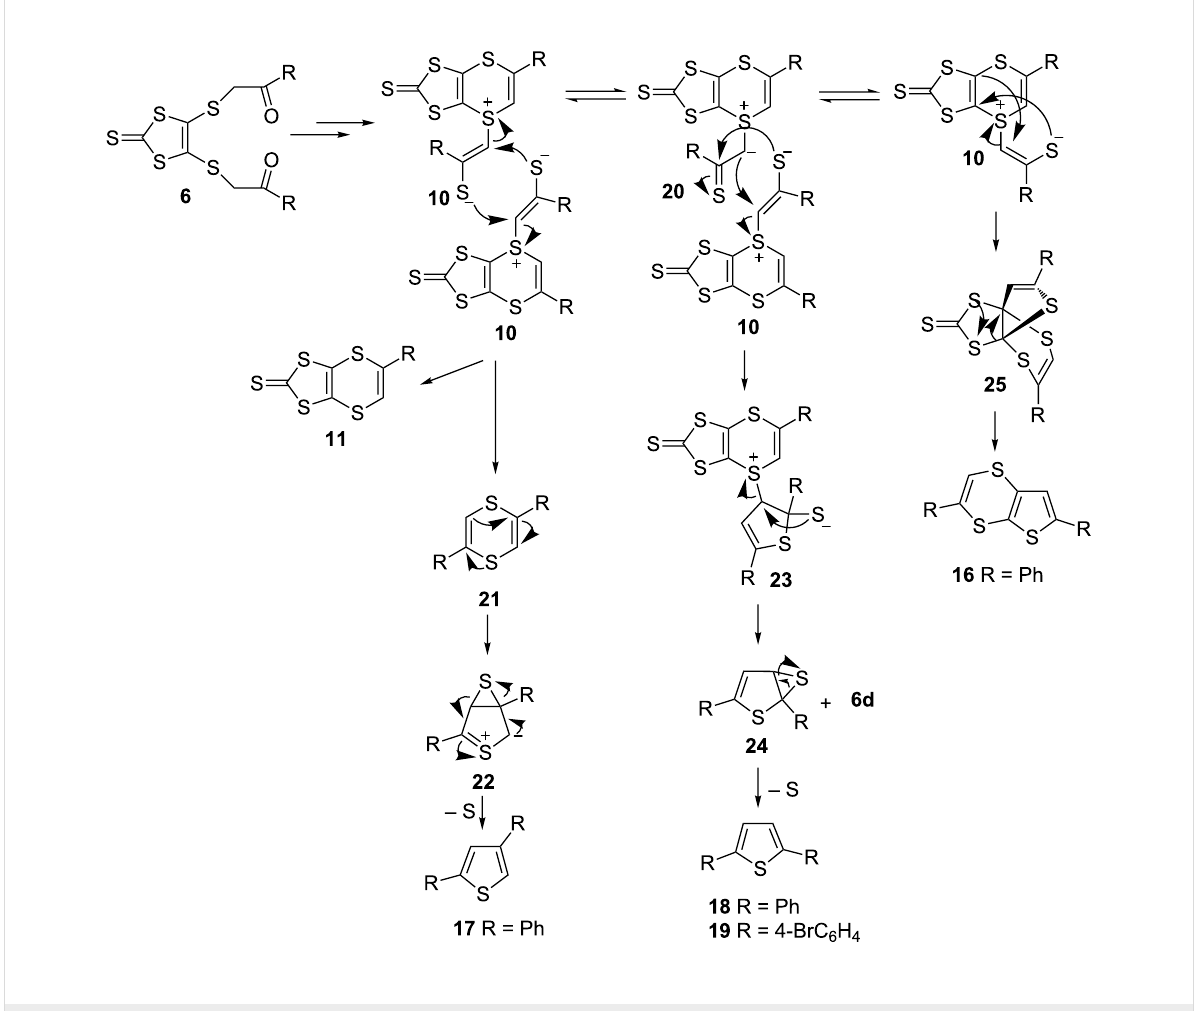
Scheme 3: Proposed mechanism for side